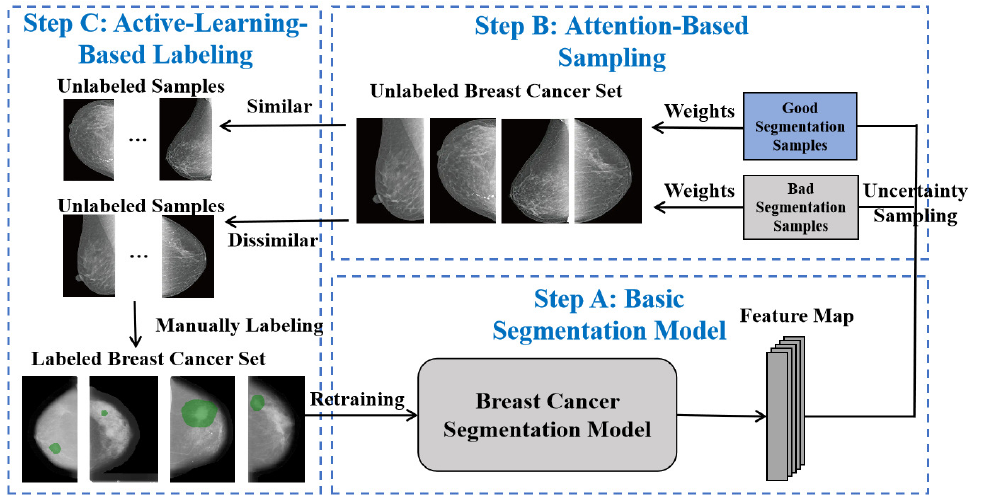
Figure 1. Framework of the proposed framework, which consists of ( A ) Basic Segmentation Model, ( B ) Attention-based Sampling, and ( C ) Active-Learning-based